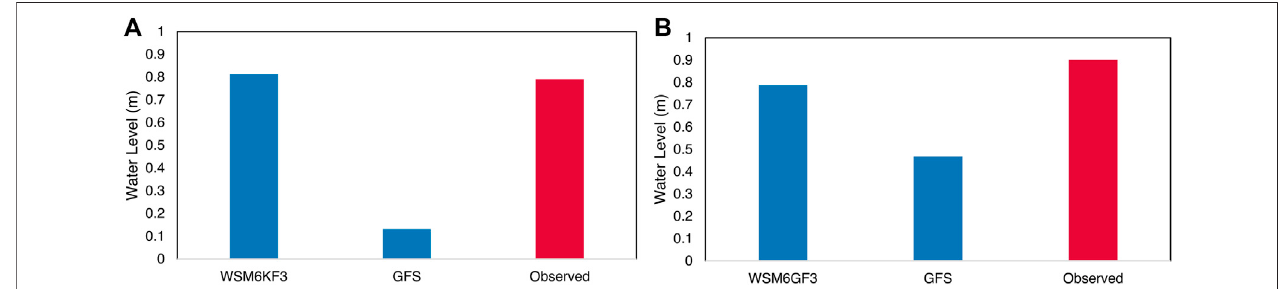
FIGURE 7 | Comparison of maximum water level at critical water level sensor locations. (A,B) , Comparison of water level between maximum value from WRF ensembleforecast,GFSforecastandobserveddataatsensorlocationinKoramangala-Chellaghattavalley (A) ,andVrishabhavathivalley (B) .ThebiasbetweentheWRF ensemble and the GFS is 0.68 and 0.32 m. The fl ood maximum value is predicted by the WRF ensemble at both